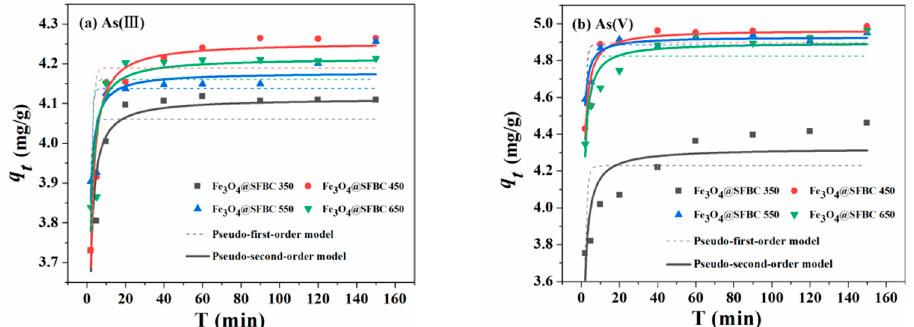
Figure 4. Adsorption kinetics of As(III) ( a ) and As (V) ( b ) on Fe 3 O 4 @SFBC (prepared from biochar at different calcination temperatures) (experimental conditions: pH = 6 and 4, dose = 1 g/L, initial concentration = 5 mg/L, T = 25 °C).